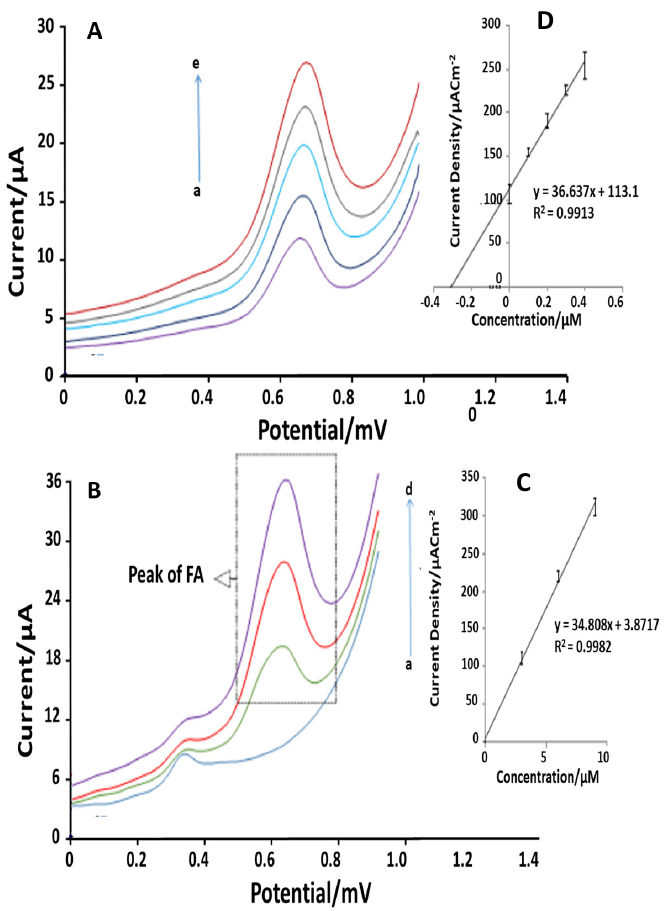
Figure 5. ( A ): Differential pulse voltammograms of CPE in 0.1 M PB (pH = 8.0) and drug tablet (3.0 μ M FA) containing different concentrations of pure FA: a–e corresponds to 0.0–4.0 μ M of pure FA. ( B ): Standard addition curve of the peak current density J ( μ M cm − 2 ) vs. the concentration of FA. ( C ): Differential pulse voltammograms of CPE in 0.1 M PB (pH = 8.0) and 0.2 mL of a urine sample